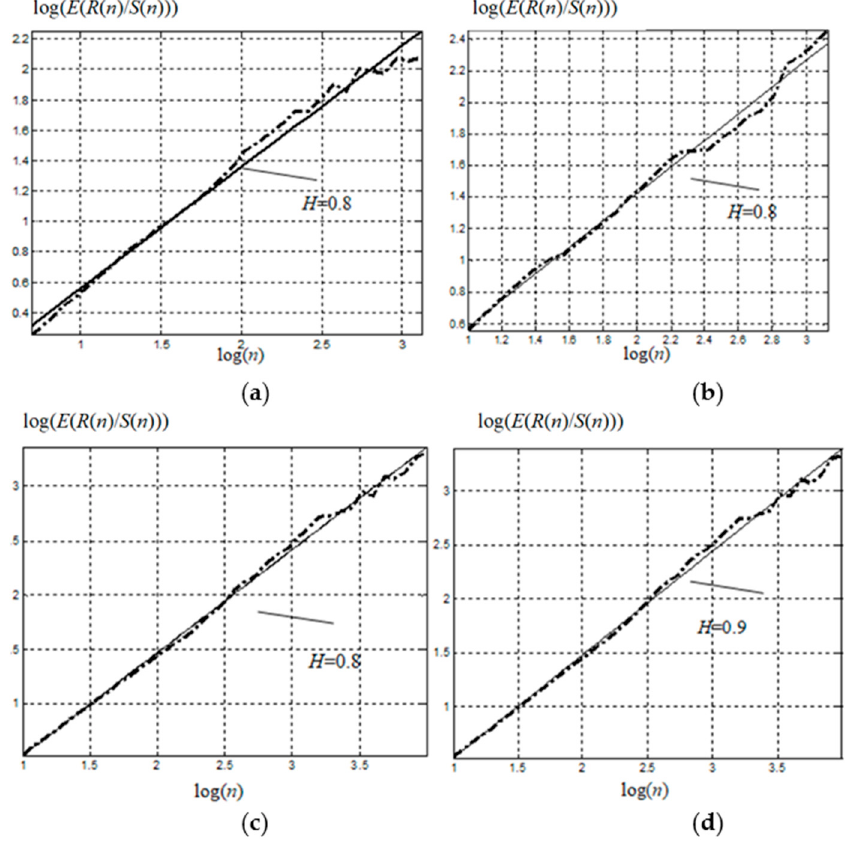
Figure 6. Characteristics of information and telecommunication systems: ( a ) and ( c ) show the anal- ysis of 2-month, and weekly, series of intensity, respectively, in bytes; ( b ) and ( d )—in packages. 2-month, and weekly, series of intensity, respectively, in bytes; ( b , d )—in